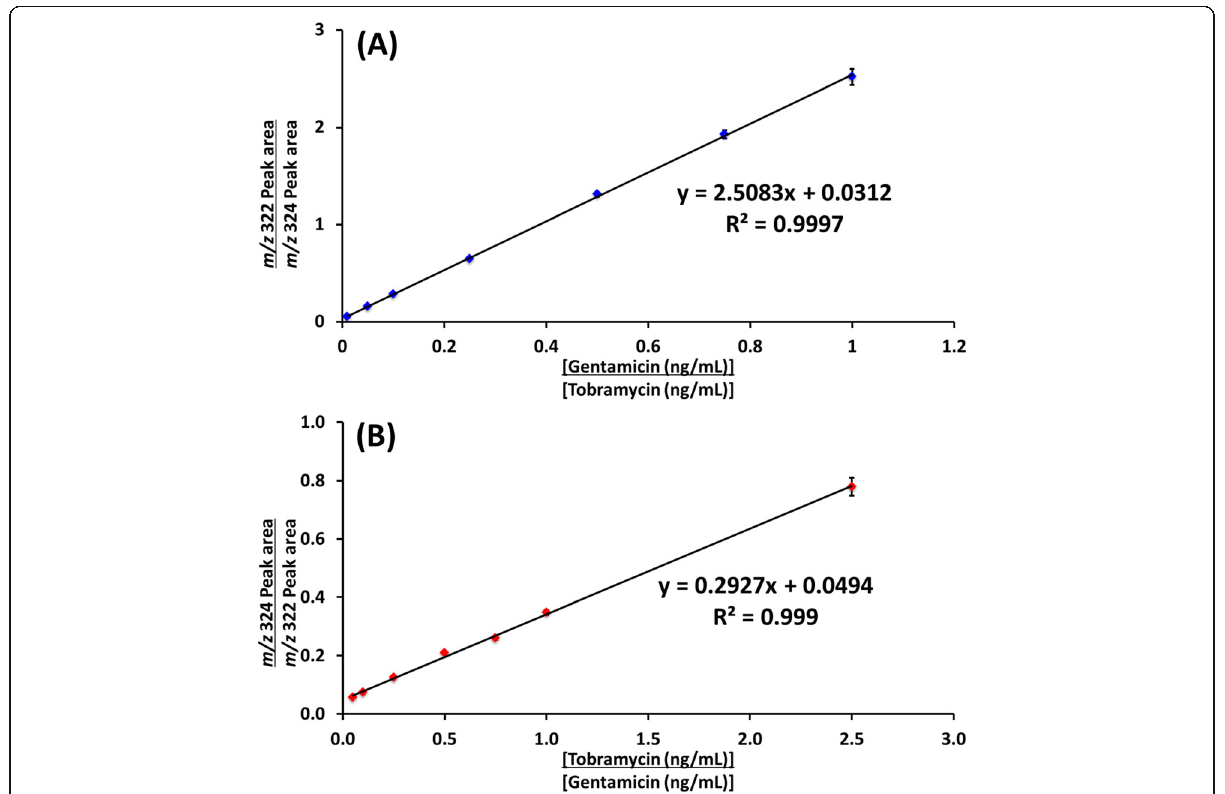
Fig. 6 Representative linear regression curves generated using the internal standard method for quantification of gentamicin with tobramycin as internal standard ( a ) and tobramycin with gentamicin as internal standard ( b ). Error bars smaller than the width of the data-point bullets are not